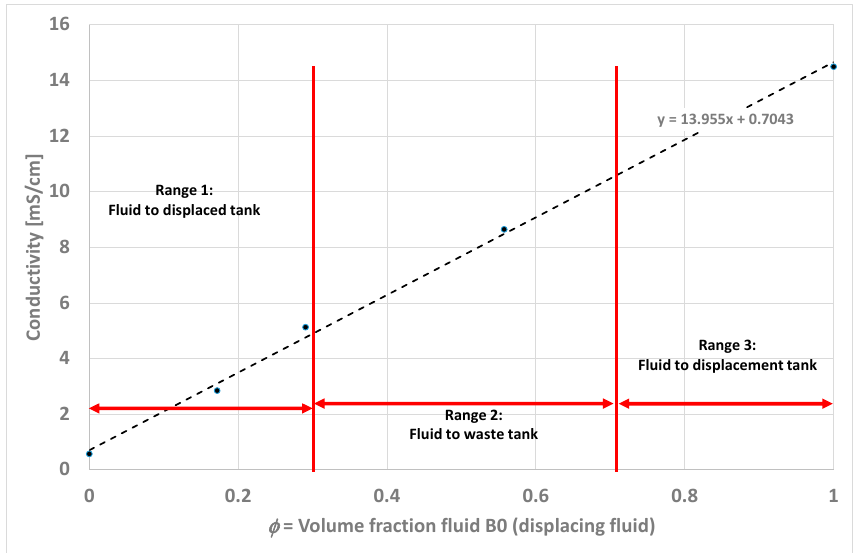
Figure 8. Measured conductivity (points) versus volume fraction of fluid B0. Stippled line shows the linear regression of the measurement points.